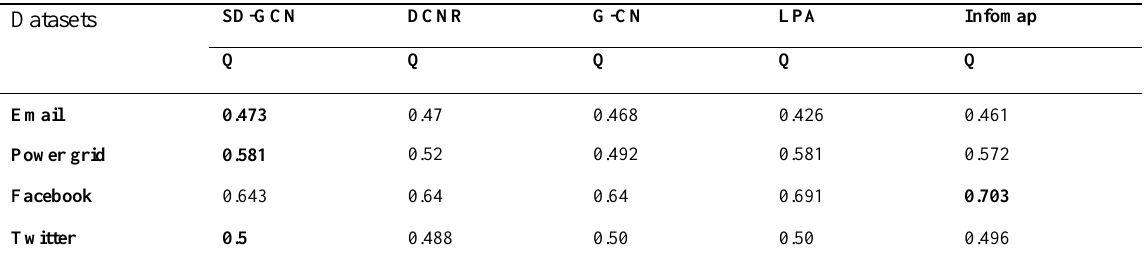
Table 6. Experimental results on real-world networks without ground-truth communities.